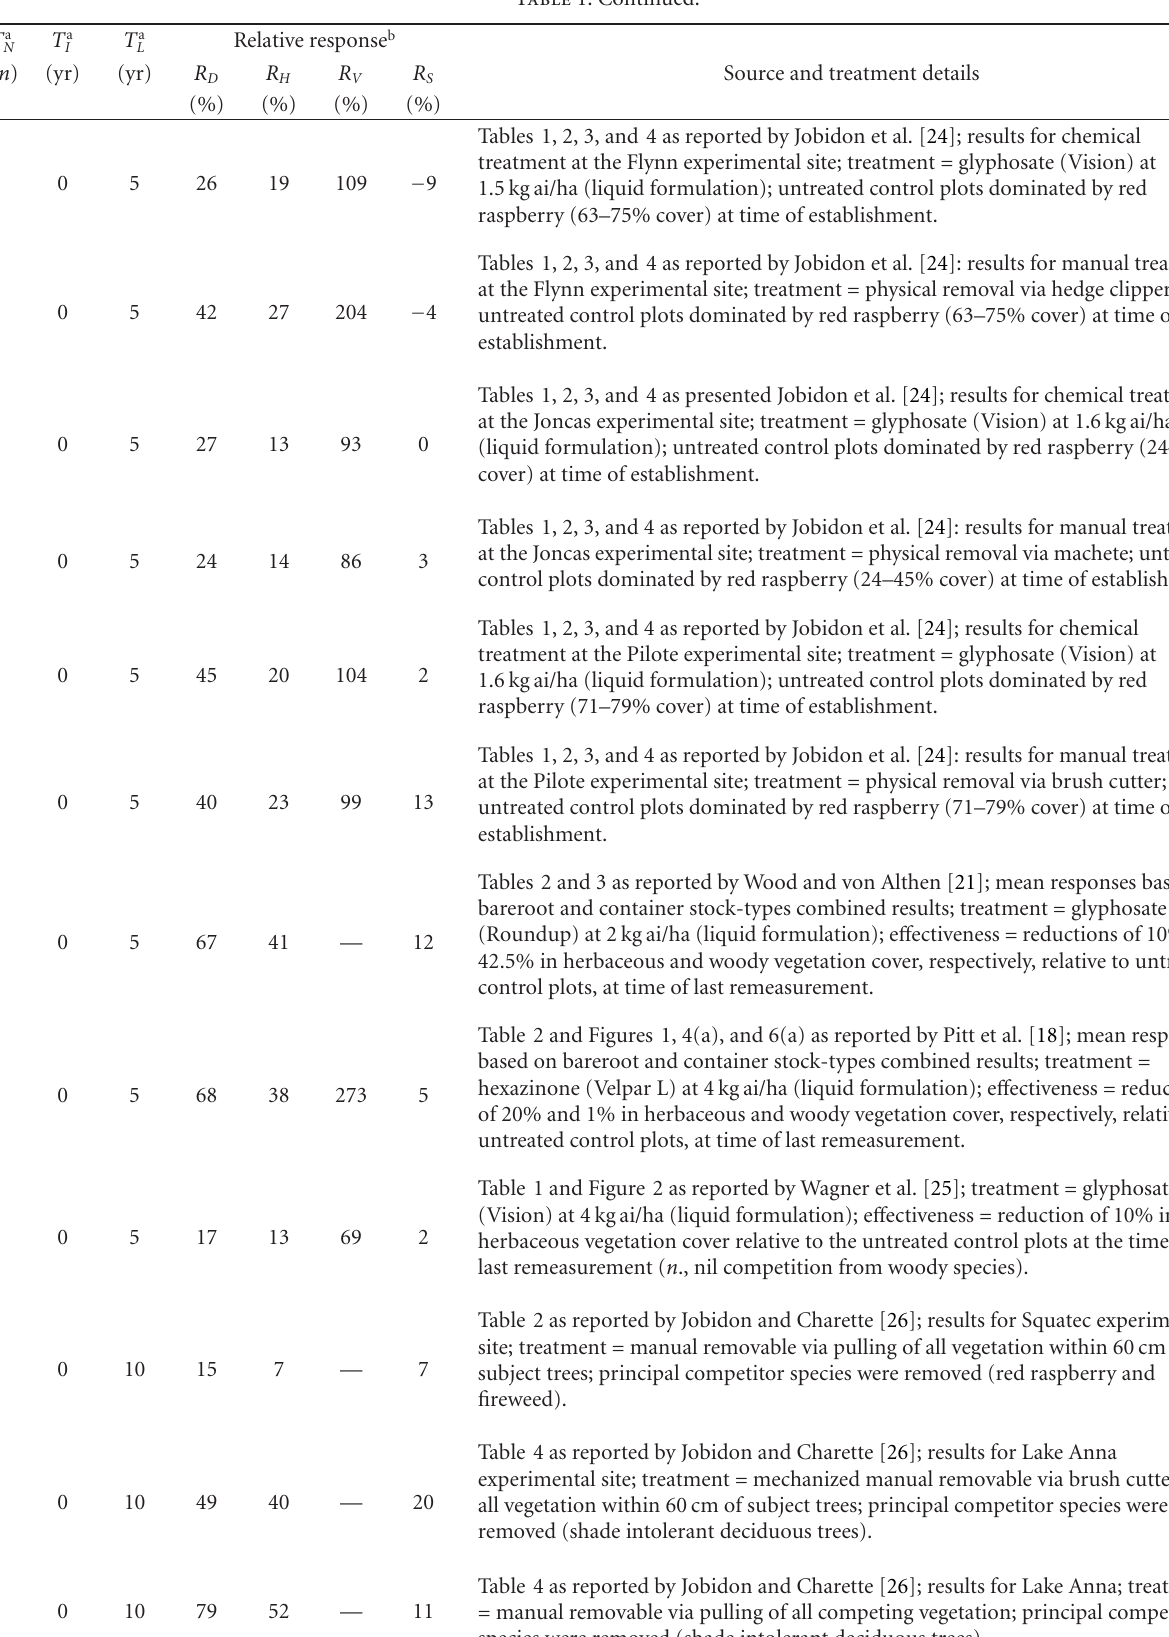
Table 4 as reported by Jobidon and Charette [26]; results for Lake Anna; treatment = manual removable via pulling of all competing vegetation; principal competitor species were removed (shade intolerant deciduous